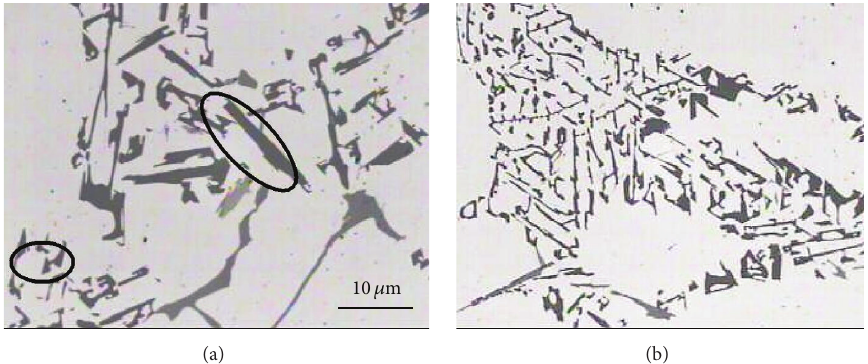
Figure 10: Size and distribution of eutectic Si particles in (a) T6 and (b) T6S 356 alloys.